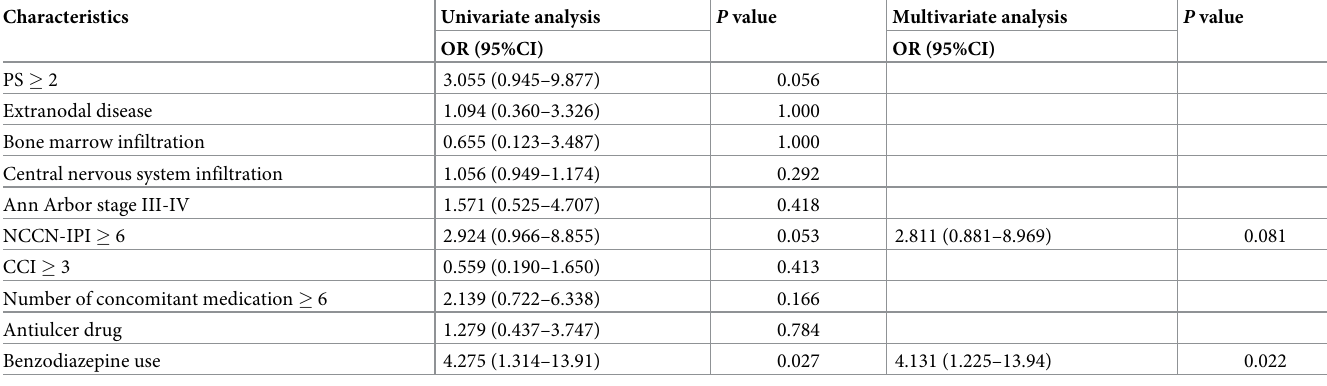
Table 3. Univariate and multivariate analyses of the risk factors for infection.